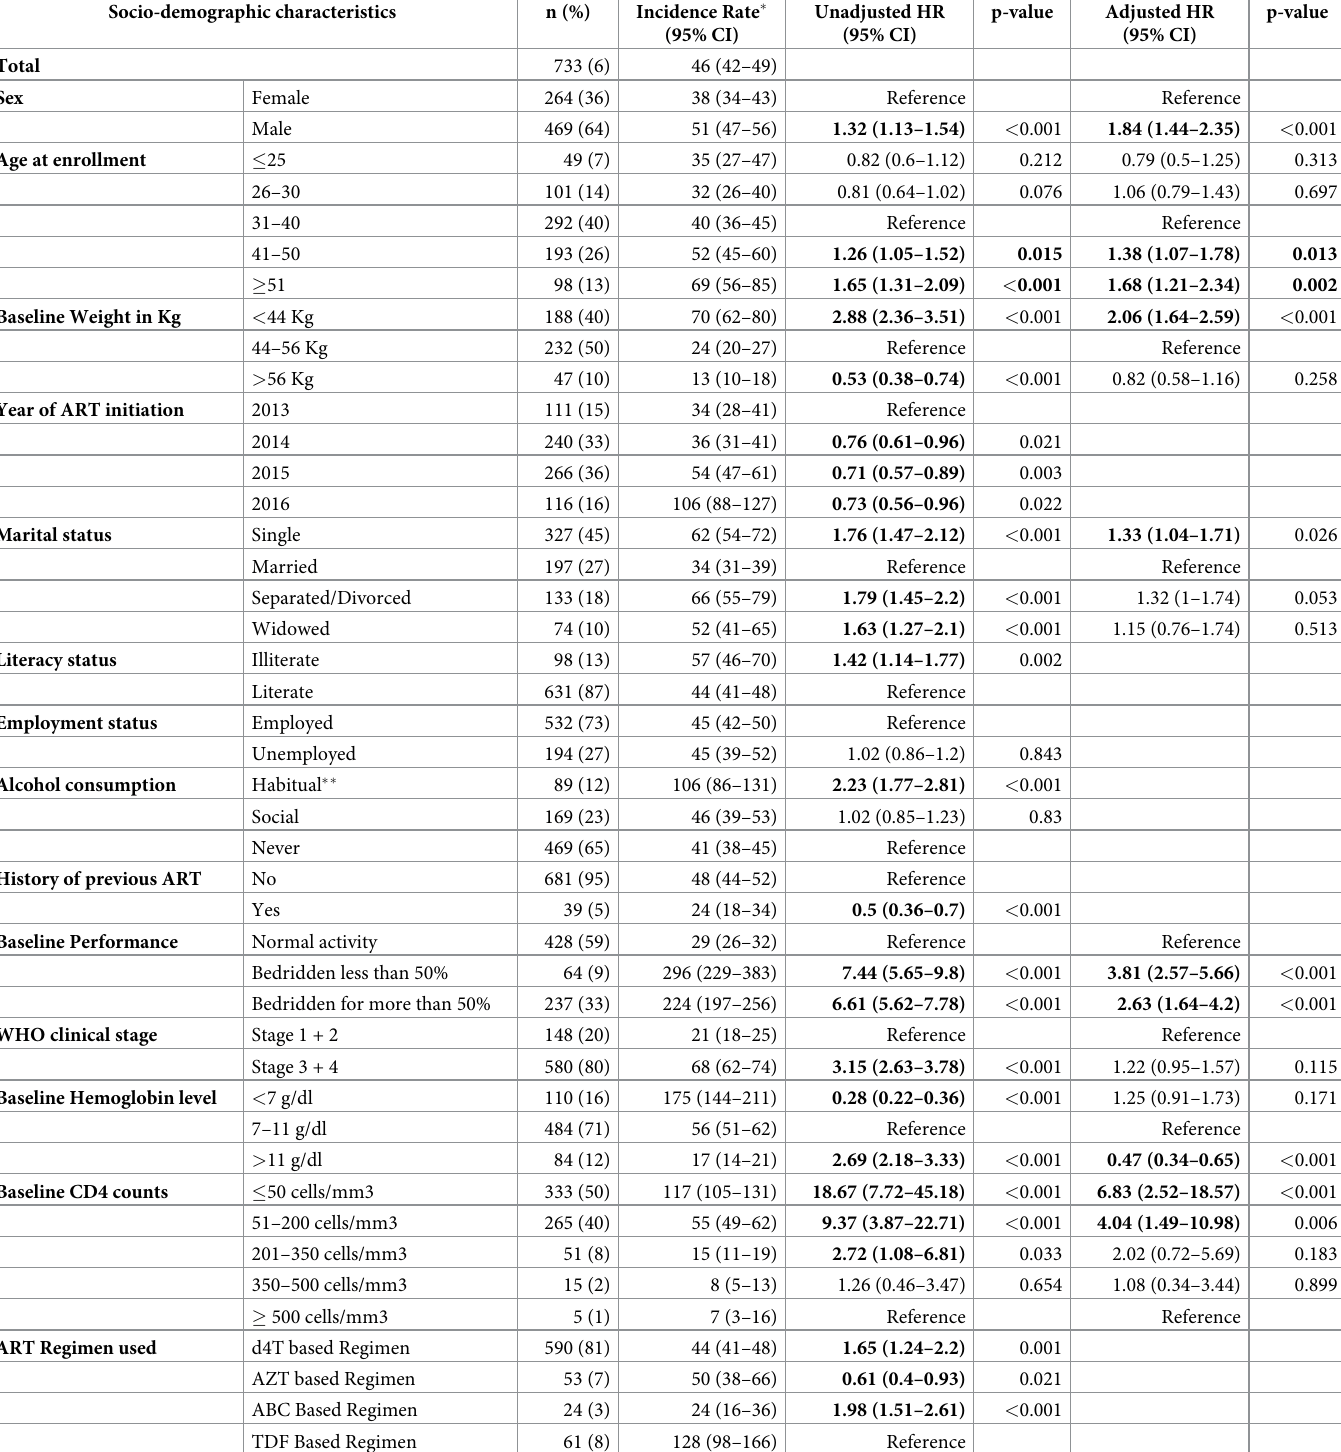
Table 2. Factors associated with early mortality within 6 months after ART initiation among people living with HIV who were enrolled in three hospitals specializ- ing for HIV care in Yangon, Myanmar, 1 st June 2013 to 30 th June 2016. Socio-demographic